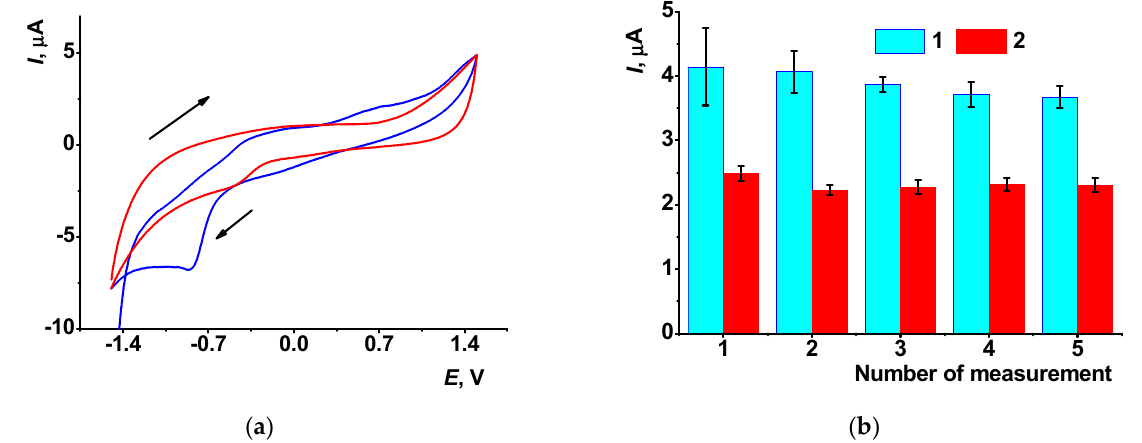
Figure 1. ( a ) Cyclic voltammogram of 1.0 µM AY in 0.025 M phosphate buffer containing 0.1 M NaNO 3 , pH = 7.0, on the bare GCE, 100 mV/s. Arrows indicate direction of the potential scamming. ( b ) Cathodic AY peak currents in the series of consecutive measurements on the same bare glassy carbon (1) and that covered with the CB suspension in chitosan (2). Average ± s. d. for six replications on individual electrodes.